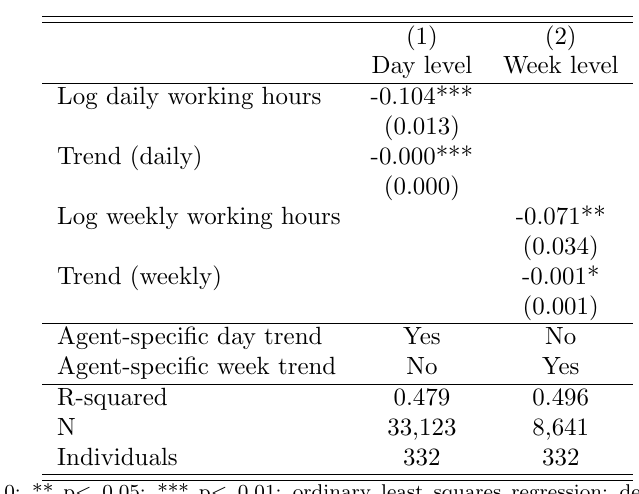
Table 7: Individual-specific time trends and the relationship between pro- ductivity and working time